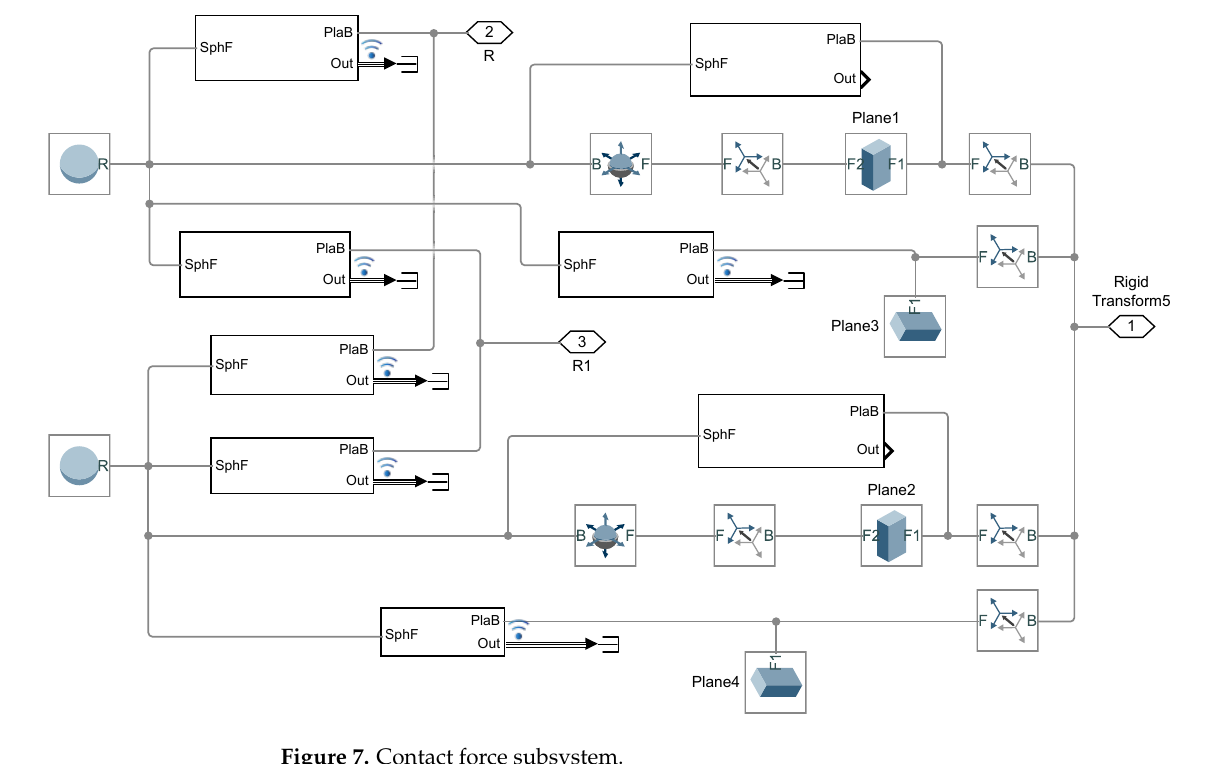
Figure 7. Contact force subsystem.